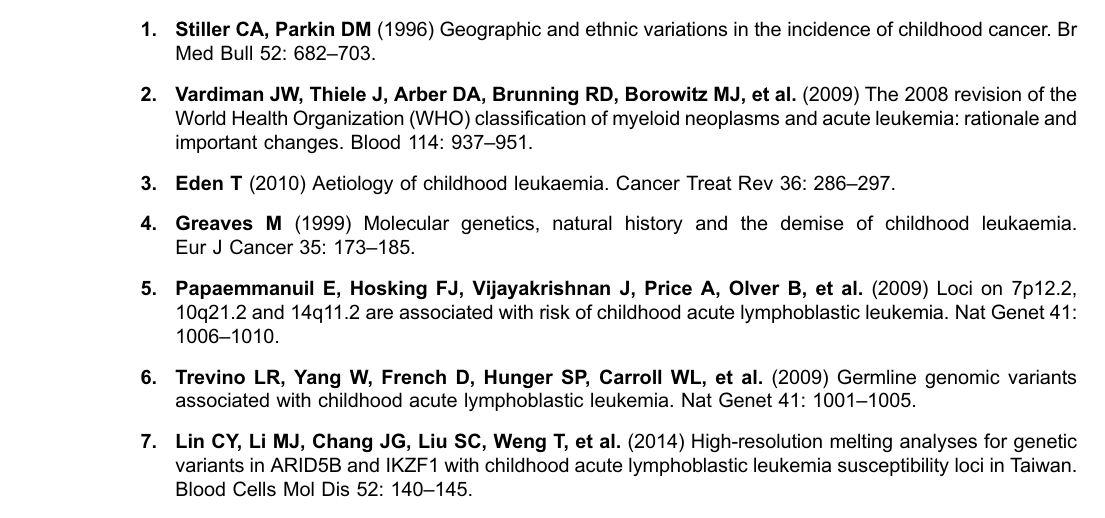
Figure S2. Cumulative meta-analysis: pooled OR with the corresponding 95% CI at the end of each year information step is shown for IKZF1 rs11978267 polymorphism in allelic contrast model (G vs A). CI: confidence interval; OR: Odds ratio. Figure S3. Galbraith plots of IKZF1 rs4132601 (A) or rs11978267 (B) polymorphism and childhood AL risk, which indicated the outliers as possible sources of heterogeneity. The regression runs through the origin interval (central solid line). The 95% confidence interval is between the two outer parallel lines at two units above and below the regression line. Table S1. Scale for quality assessment. Table S2. P value for the Egger’s test in the analysis of publication